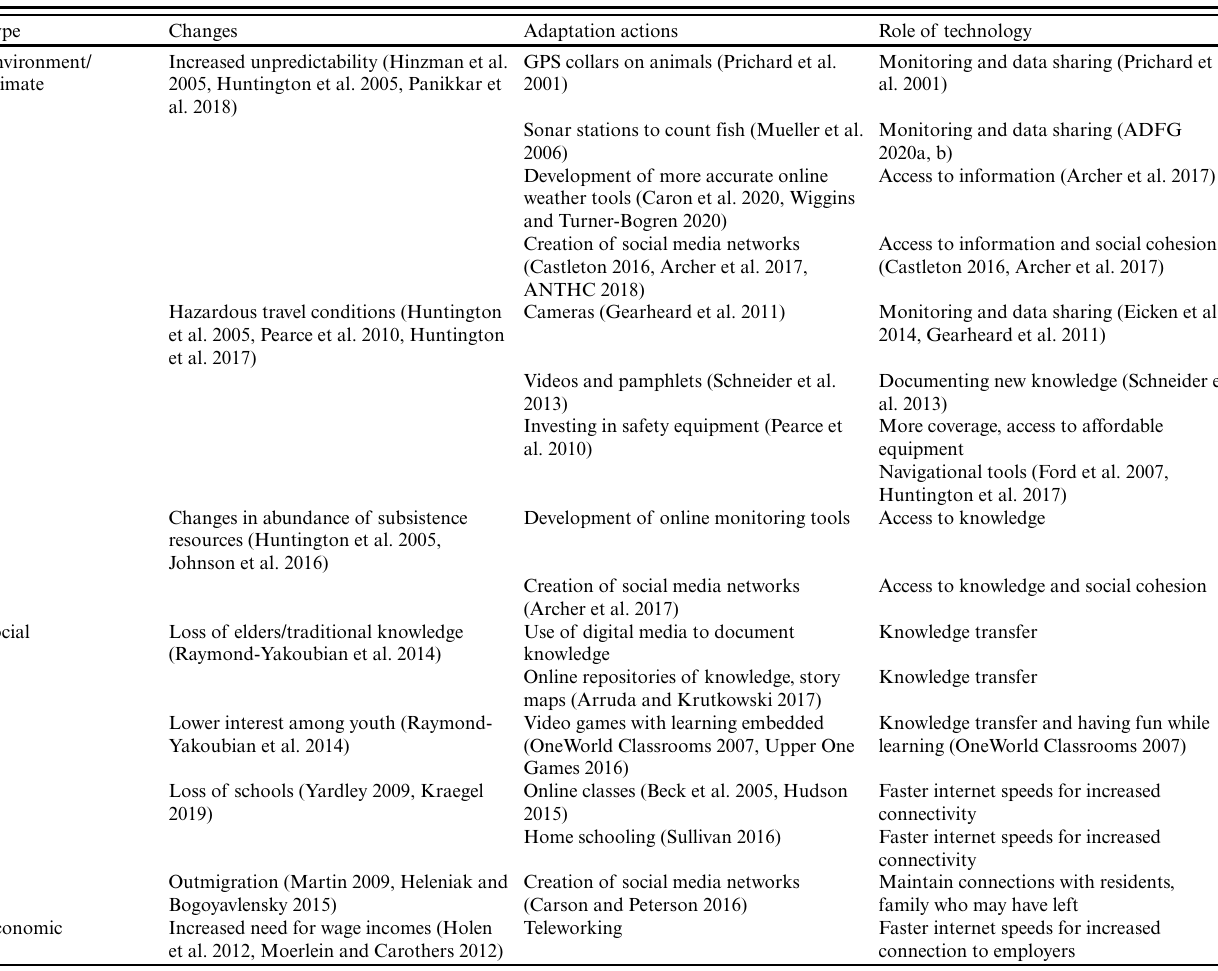
Table 1 . Changes facing remote communities in the Arctic, actual or potential adaptation actions, and ways that technology could be